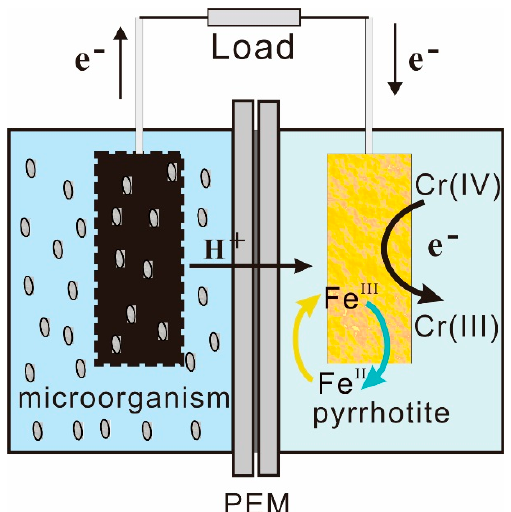
Figure 1. Schematic representation of microbial fuel cell (MFC) with pyrrhotite-coated graphite cathode.